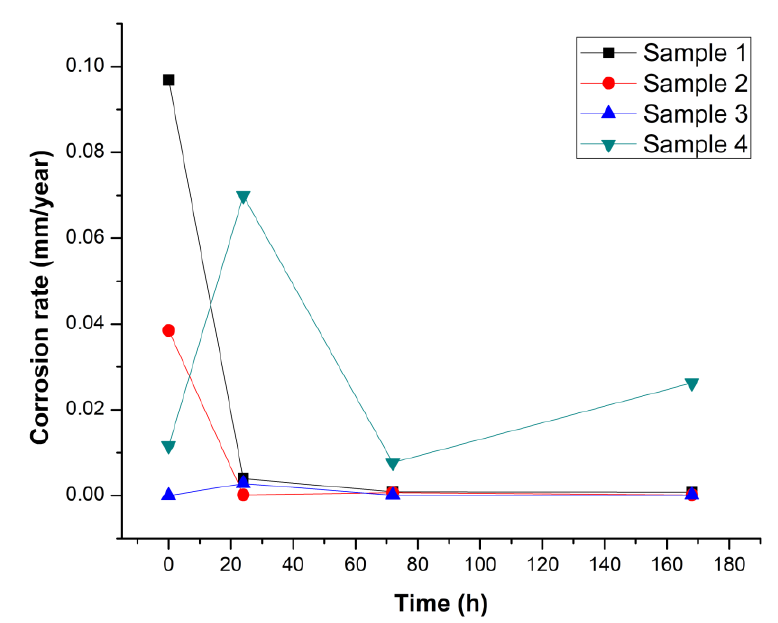
Figure 7. Tafel diagrams for Samples 1 ( a ), 2 ( b ), 3 ( c ), and 4 ( d ) at different electrolyte solution immersion times.